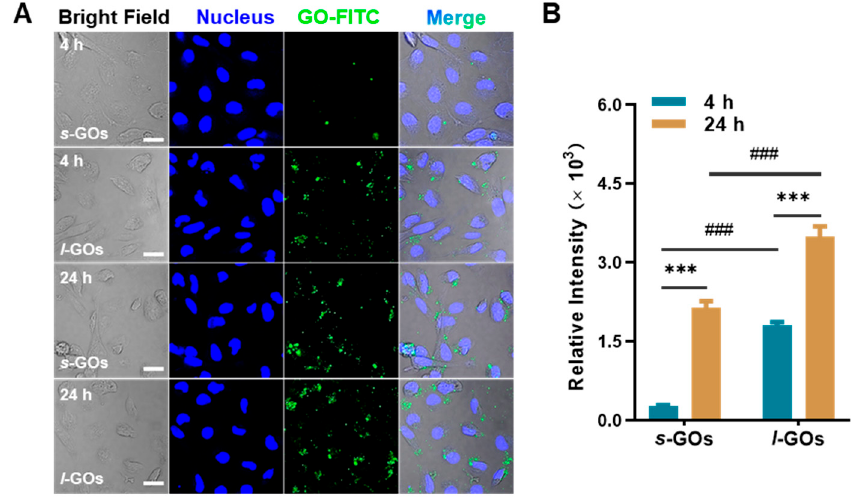
Figure 6. ( A ) Cellular uptake of s ‐ GOs and l ‐ GOs in HK ‐ 2 cells was observed by confocal laser scan ‐ ning microscopy. HK ‐ 2 cells were co ‐ cultured with 10 μ g/mL s ‐ GO/FITC and l ‐ GO/FITC for 4 h and 24 h. Nucleus was stained by DAPI (blue); GOs were labeled by FITC ‐ BSA (green). Scale bar = 20 μ m. ( B ) Quantitative results of cellular uptake of GO/FITC in HK ‐ 2 cells. *** p < 0.001 indicates a significant difference between GO − treated group and the control group. ### p < 0.001 indicates a significant difference between s ‐ GO − and l ‐ GO − treated groups.